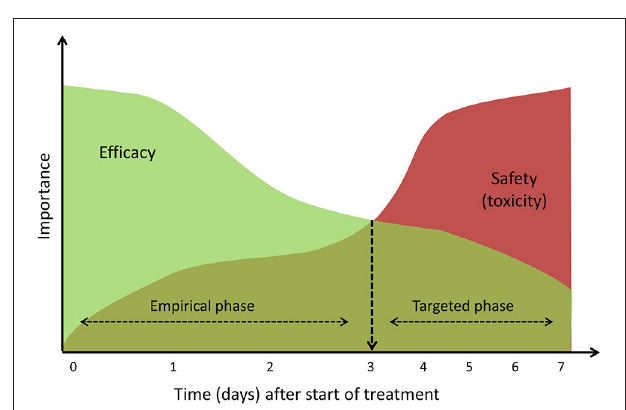
FIGURE 2 | Conceptual visualization of impact of efficacy and toxicity during antibiotic treatment. During the empirical phase, focus lies on an efficacious treatment and when sepsis is confirmed ( ∼ 3 days) treatment can be individualized and focus should shift to the safety of